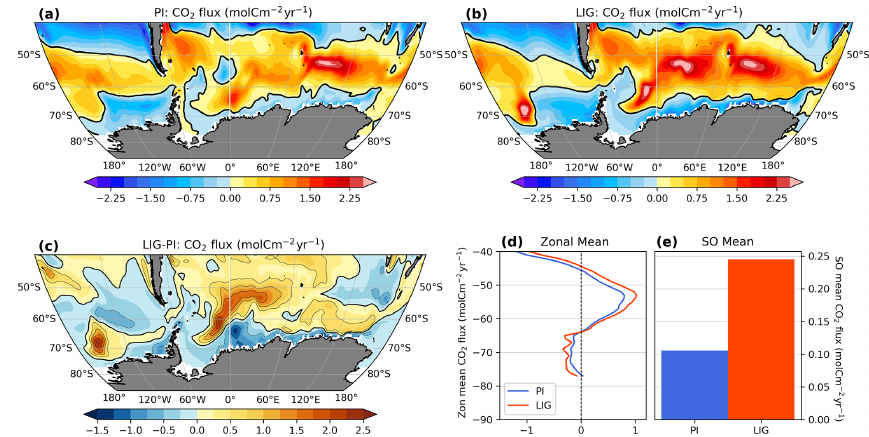
Figure 2. Annual mean air–sea CO 2 flux (molCm − 2 yr − 1 ) for (a) PI, (b) LIG, and (c) LIG − PI. Red colours indicate outgassing of CO 2 from the ocean, and blue colours indicate uptake by the ocean. Thick black lines show the zero line contour. (d) Zonal mean CO 2 flux (molCm − 2 yr − 1 ) over the SO for PI (blue) and LIG (red). (e) Mean CO 2 flux over the SO (molCm − 2 yr − 1 ) for PI (blue) and LIG